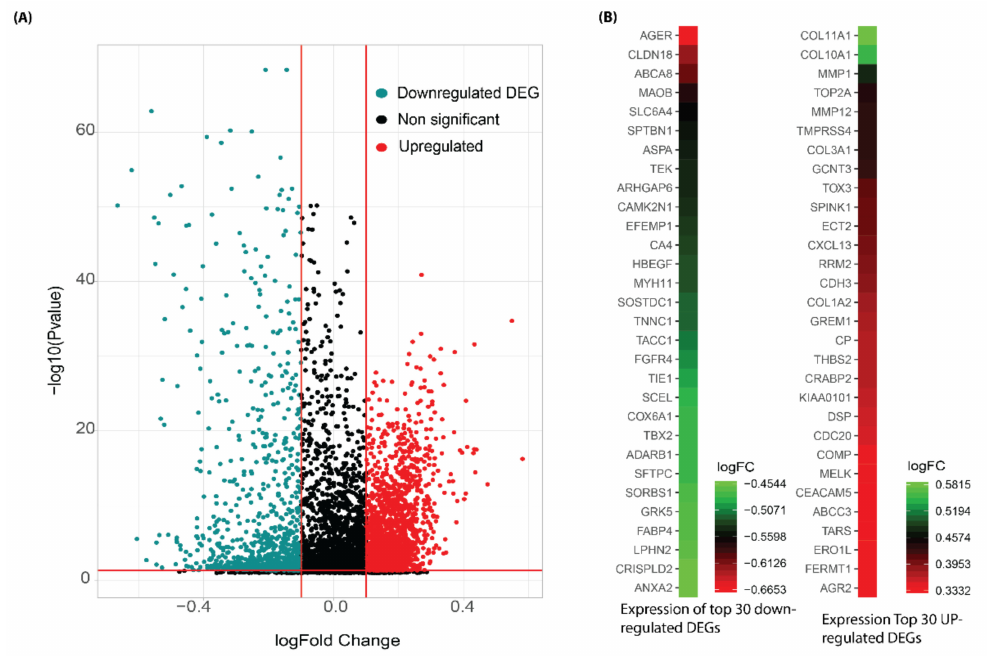
Figure 2. ( A ) Volcano plot distribution highlighting 2700 meta-DEGs between normal and tumor samples. The red and cyan colored points denote the up (1842) and downregulated (858) meta-DEGs. All the black colored points denote non-significant genes. The x and y axes represent the log2FC and − log10 p -value, respectively. ( B ) The heatmap denotes the gene expression of top-30 downregulated and upregulated and DEGs based on fold changes. DEGs identification with the volcano plot in a microarray represented the top DEGs in lung cancer cases and controls. The top DEGs follow the logFC value and p -value